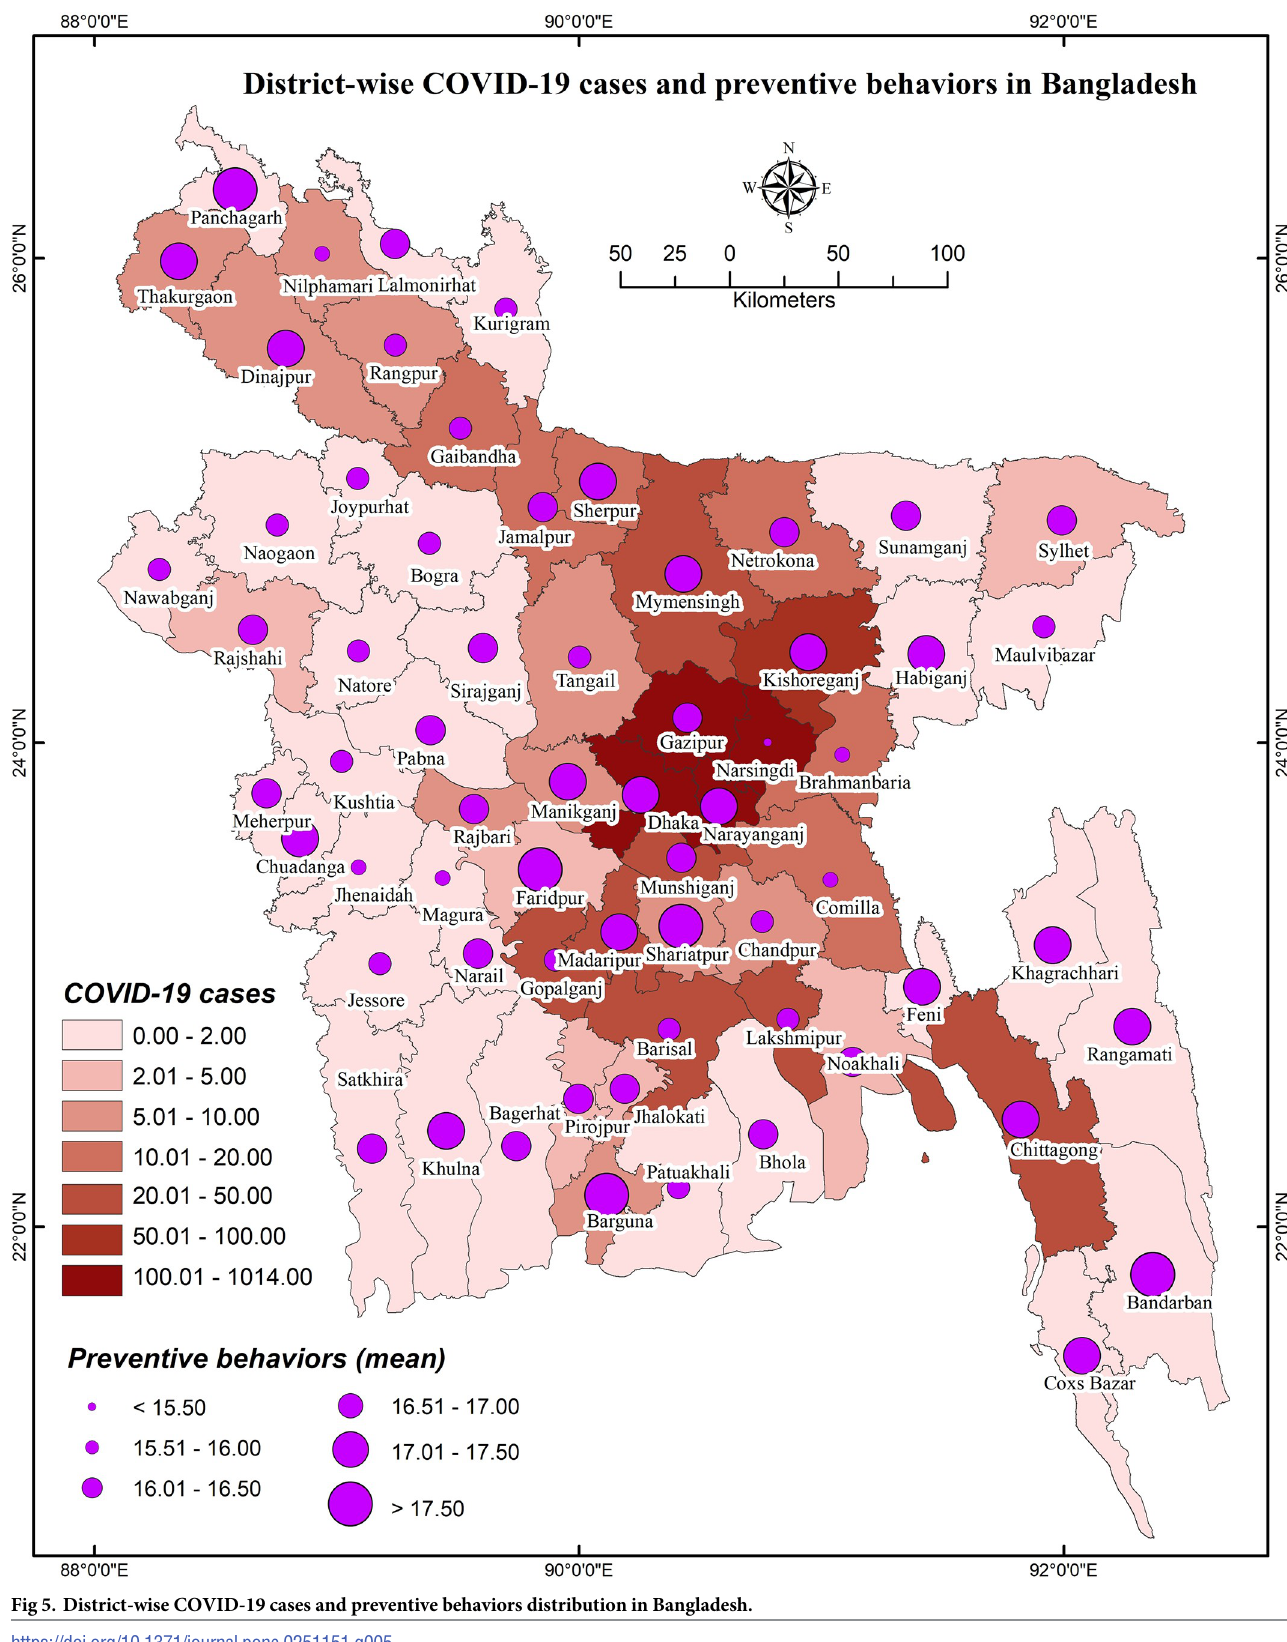
Fig 5. District-wise COVID-19 cases and preventive behaviors distribution in Bangladesh. https://doi.org/10.1371/journal.pone.0251151.g005 PLOS ONE | https://doi.org/10.1371/journal.pone.0251151 May 3,